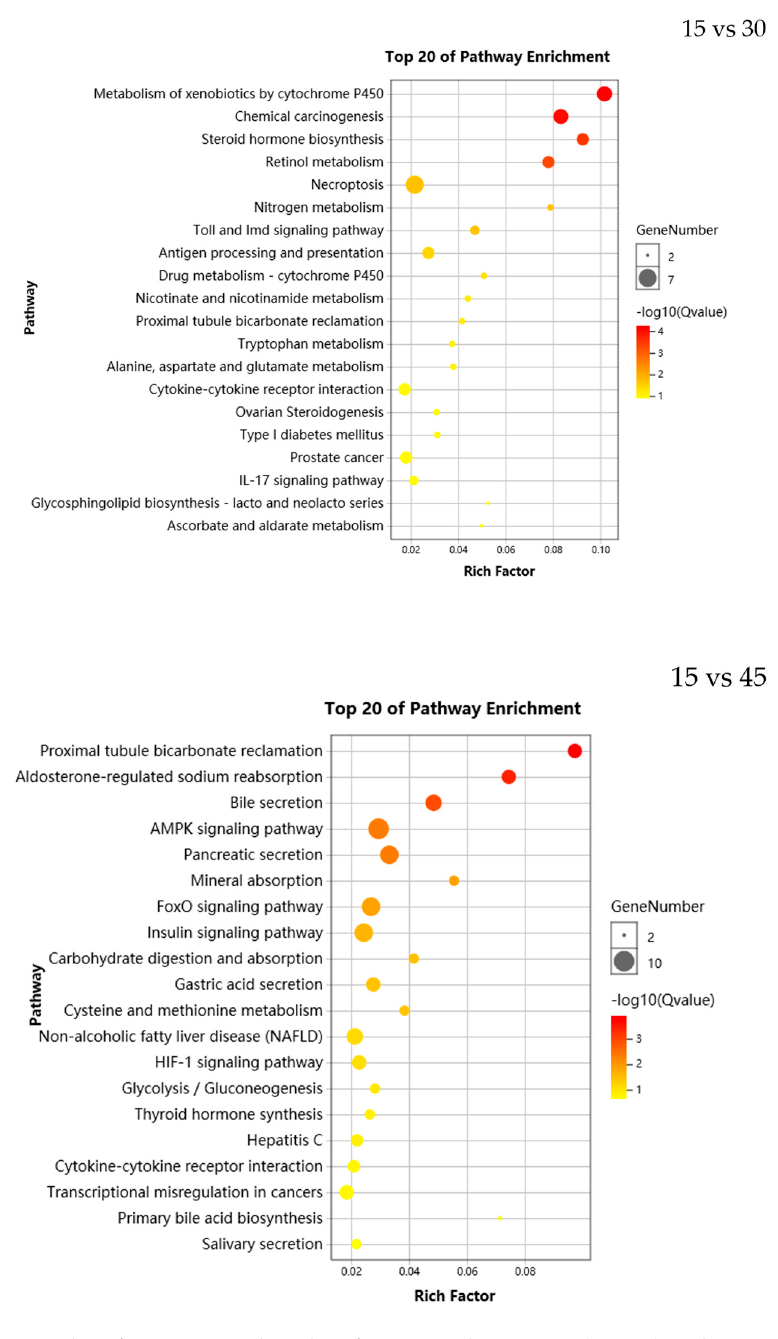
Figure 3. Scatterplot of Kyoto Encyclopedia of Genes and Genomes (KEGG) pathways enriched in the DEGs. Rich factor is the ratio of the DEGs number to the total gene number in a given pathway. The size and color of the dots represent the gene number and range of the q value, respectively.